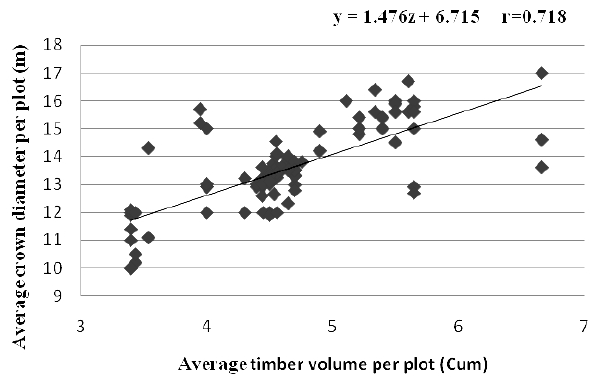
Figure 3. Relation of timber volume with crown diameter